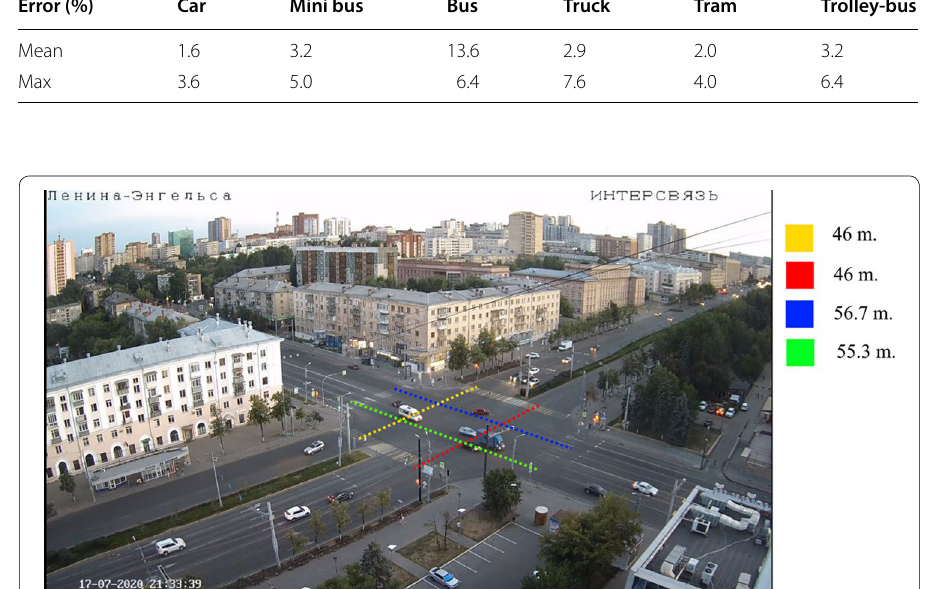
Fig. 17 Measured movement patterns and their